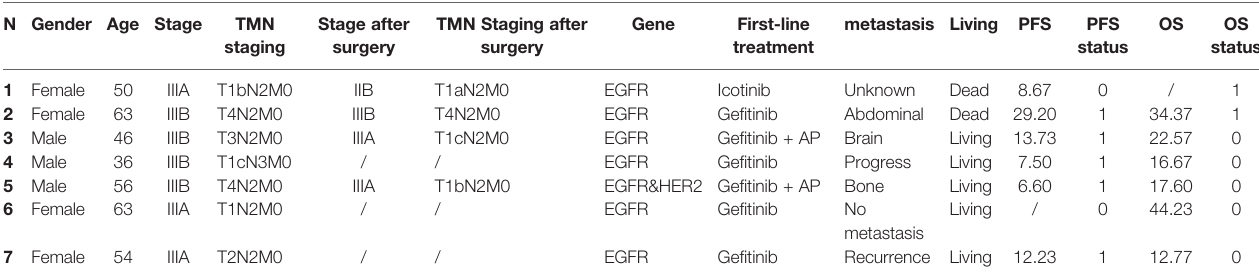
TABLE 3 | Prognosis of seven operated patients.